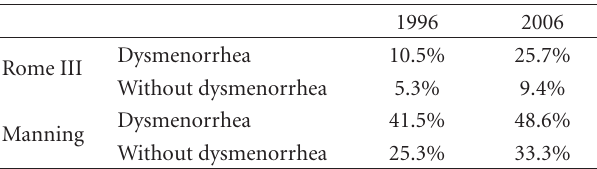
Figure 4: Functional gastrointestinal disorders and dysmenorrhea severity (2006, n = 152). Table 4: Women with IBS according to Rome III and Manning and dysmenorrhea.